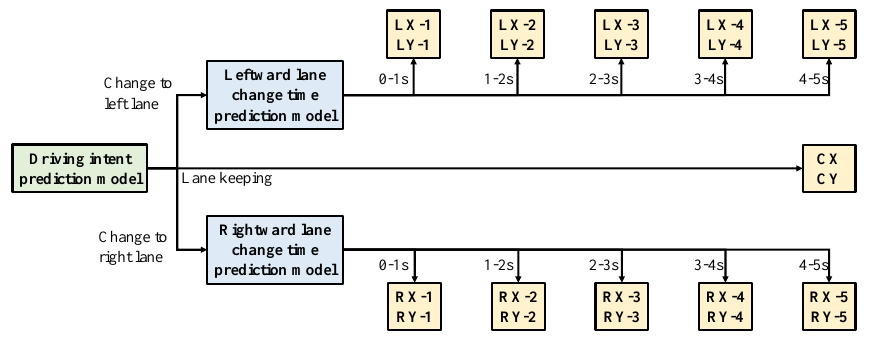
Figure 5. The logic of model invocation for each step.